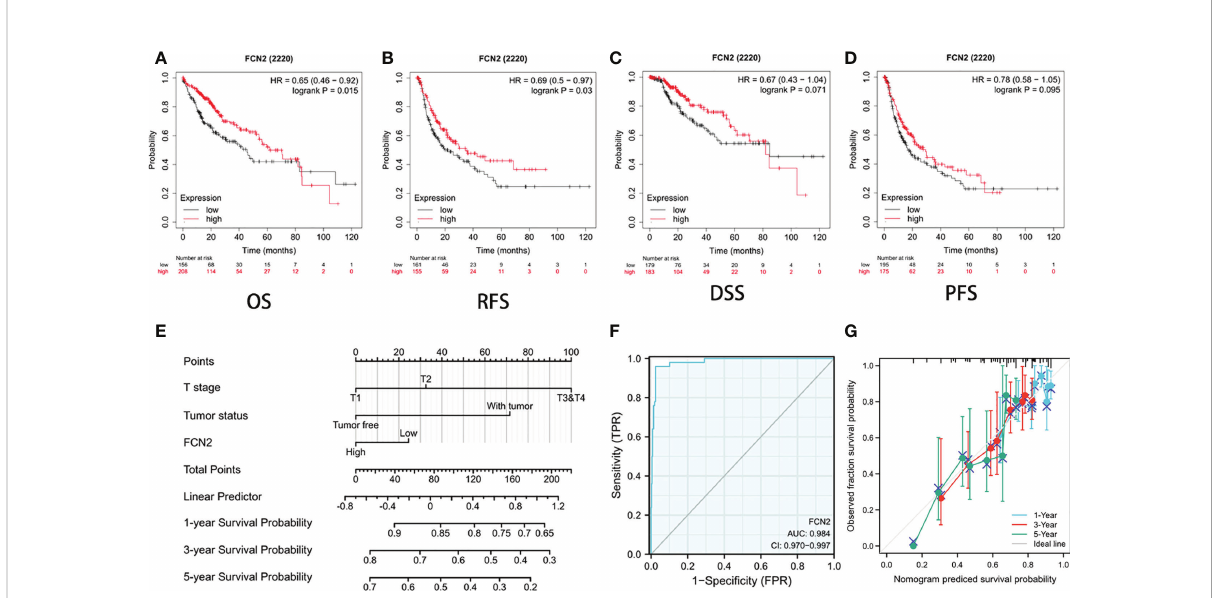
FIGURE 7 Prognostic value of FCN2 in liver cancer. (A – D) Overall survival (OS) (A) , relapse-free survival (RFS) (B) , disease-speci fi c survival (DSS) (C) , and patient-free survival/progression-free survival (PFS) (D) . (E) Nomogram predicting the 1-, 3-, and 5-year OS probability. (F) C-index of the prognostic model nomogram for predicting the 1-, 3-, and 5-year OS probability in hepatocellular carcinoma (HCC) patients. (G) Prediction of the 1-, 3-, and 5-year OS probability using nomogram calibration